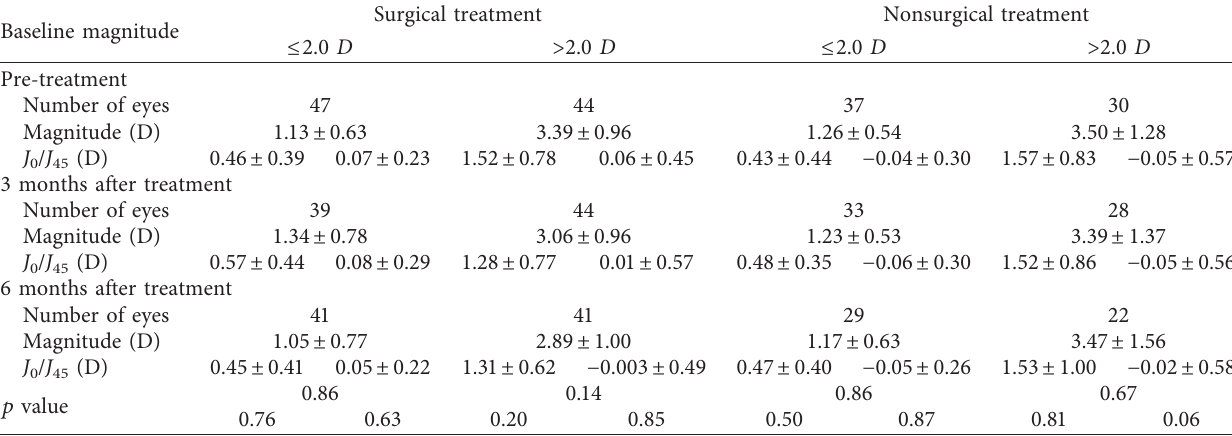
Table 5: Refractive astigmatism status of the two study groups at baseline and 3 and 6 months after treatment, stratified by baseline astigmatism magnitude ( ≤ 2.0 and > 2.0